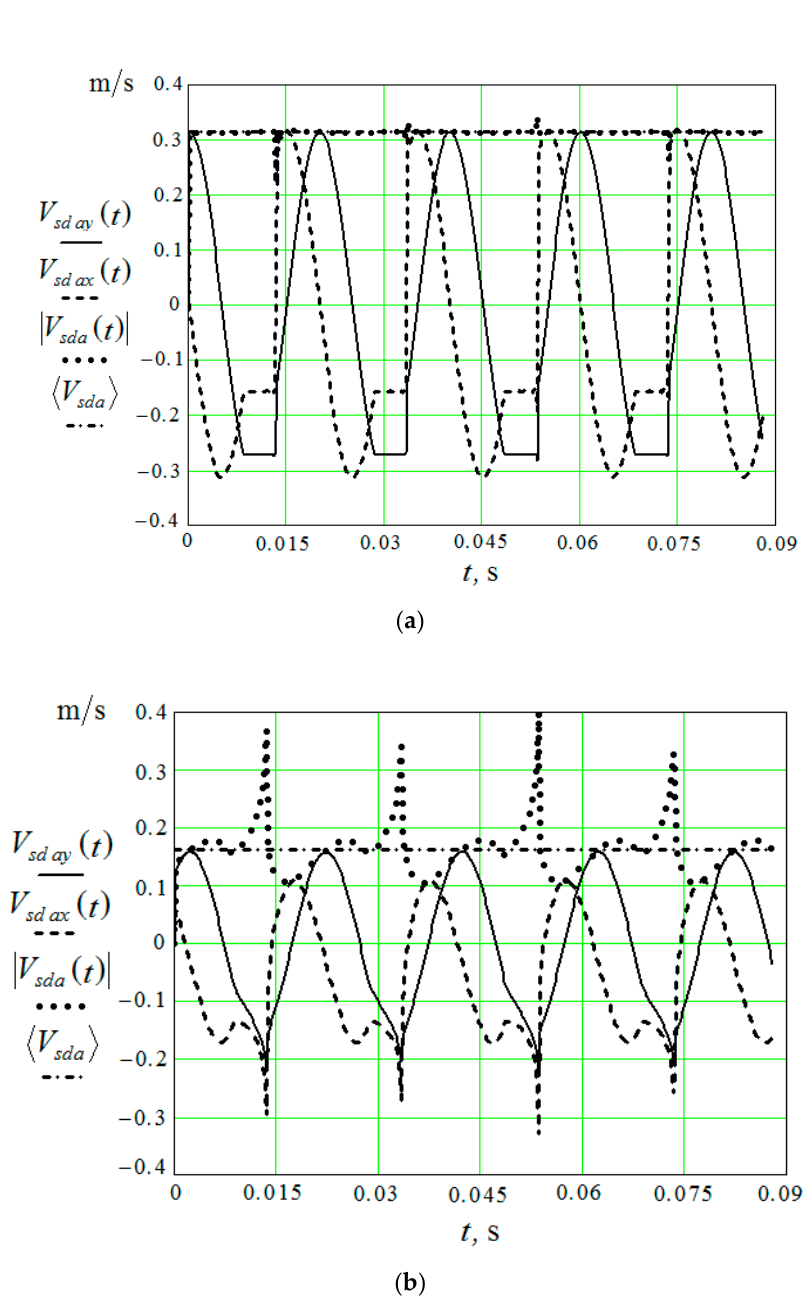
Figure 7. Horizontal and vertical component of the velocities of the pseudo-wave motion of the granules, the velocity modulus of the wave motion of the granules, the velocity of oscillatory movement of the granules under the action of an acoustic wave: ( a ) in the immediate vicinity of the reservoir working surface; and, ( b ) at a distance of 20 mm from the reservoir working surface. Points in Figure 8 show dependence (cid:104) V sda (cid:105) on the distance to the working reservoir surface calculated by Equations (14) – (30).